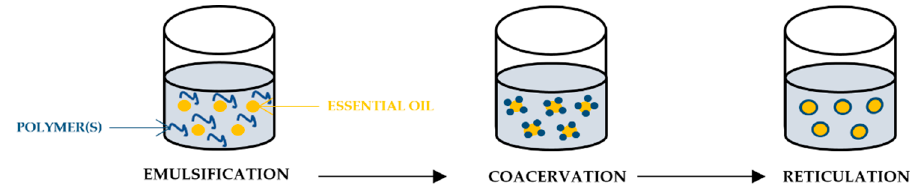
Figure 10. Schematic illustration of the coacervation method.